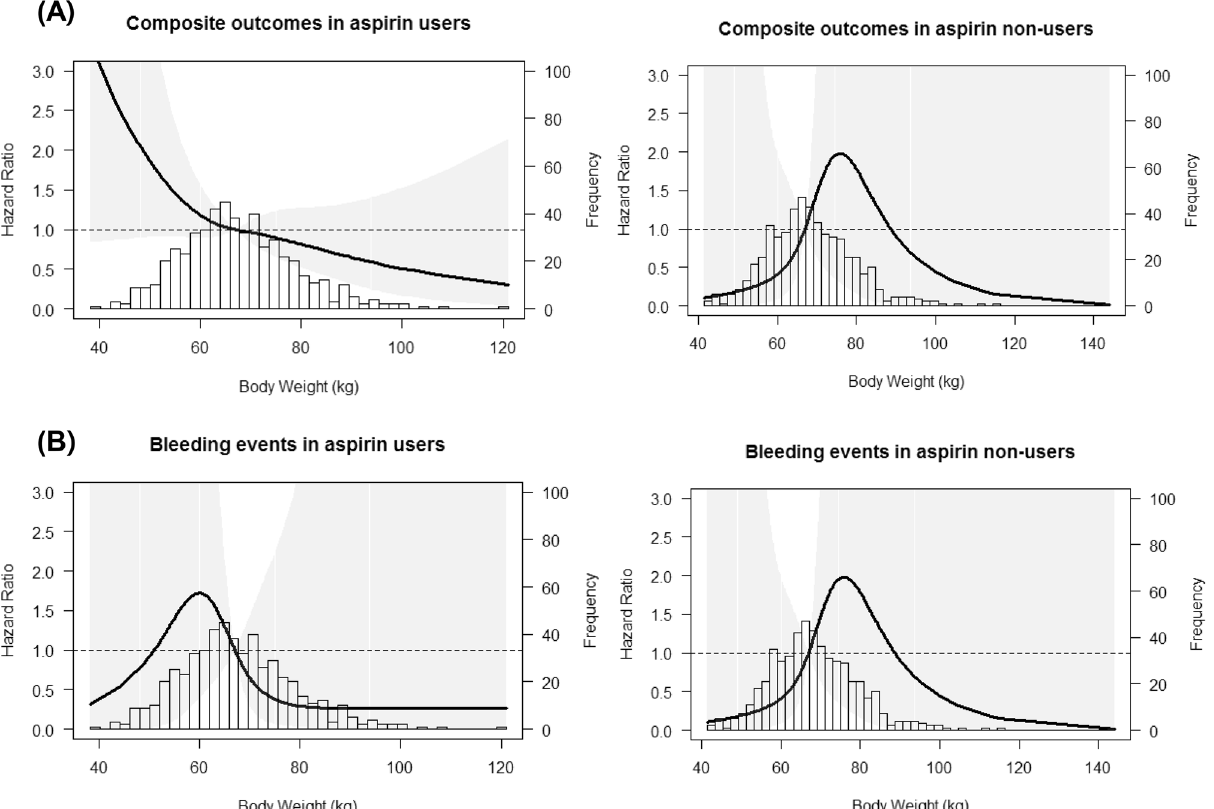
Figure 1. Adjusted risk of clinical outcomes according to body weight in aspirin users versus non-users after PS matching. The spine curves show the adjusted hazard ratio of ( A ) the composite outcome of the CVE or kidney event or death, and bleeding event, ( B ) bleeding events. Hazard ratios were adjusted for use of age, sex, BMI, smoking history, diabetes, hypertension, CVD, eGFRcr, uPCR, serum levels of hemoglobin, albumin, total cholesterol, and the use of RAAS blockers, CCBs, beta-blockers, statins, warfarin, and other antiplatelet agents. The histograms represent the frequency of distribution of body